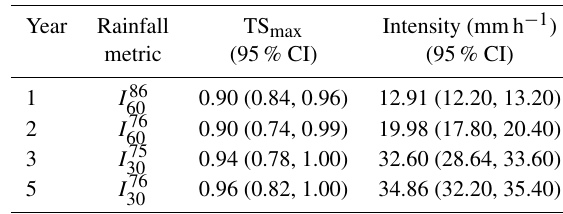
Table 3. The ROC-based optimal metrics of rainfall ID and corre- sponding rainfall thresholds for flash floods in post-fire year